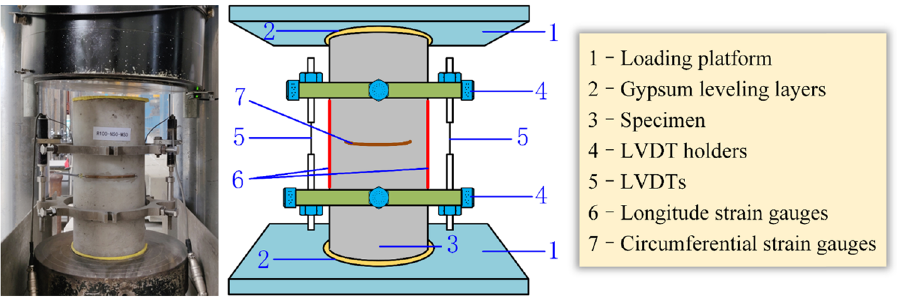
Figure 4: Photograph and sketch of the uniaxial compression test for elastic properties.